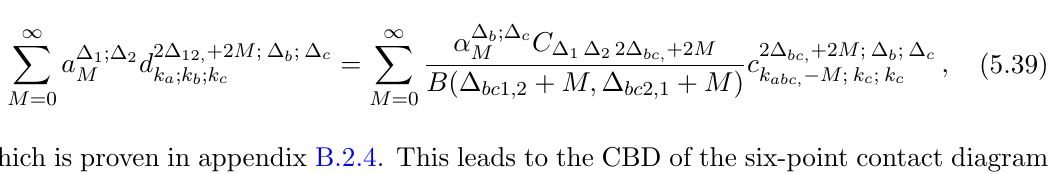
of the hypergeometric identities mentioned above. The key identity required for the CBD of the six-point contact diagram